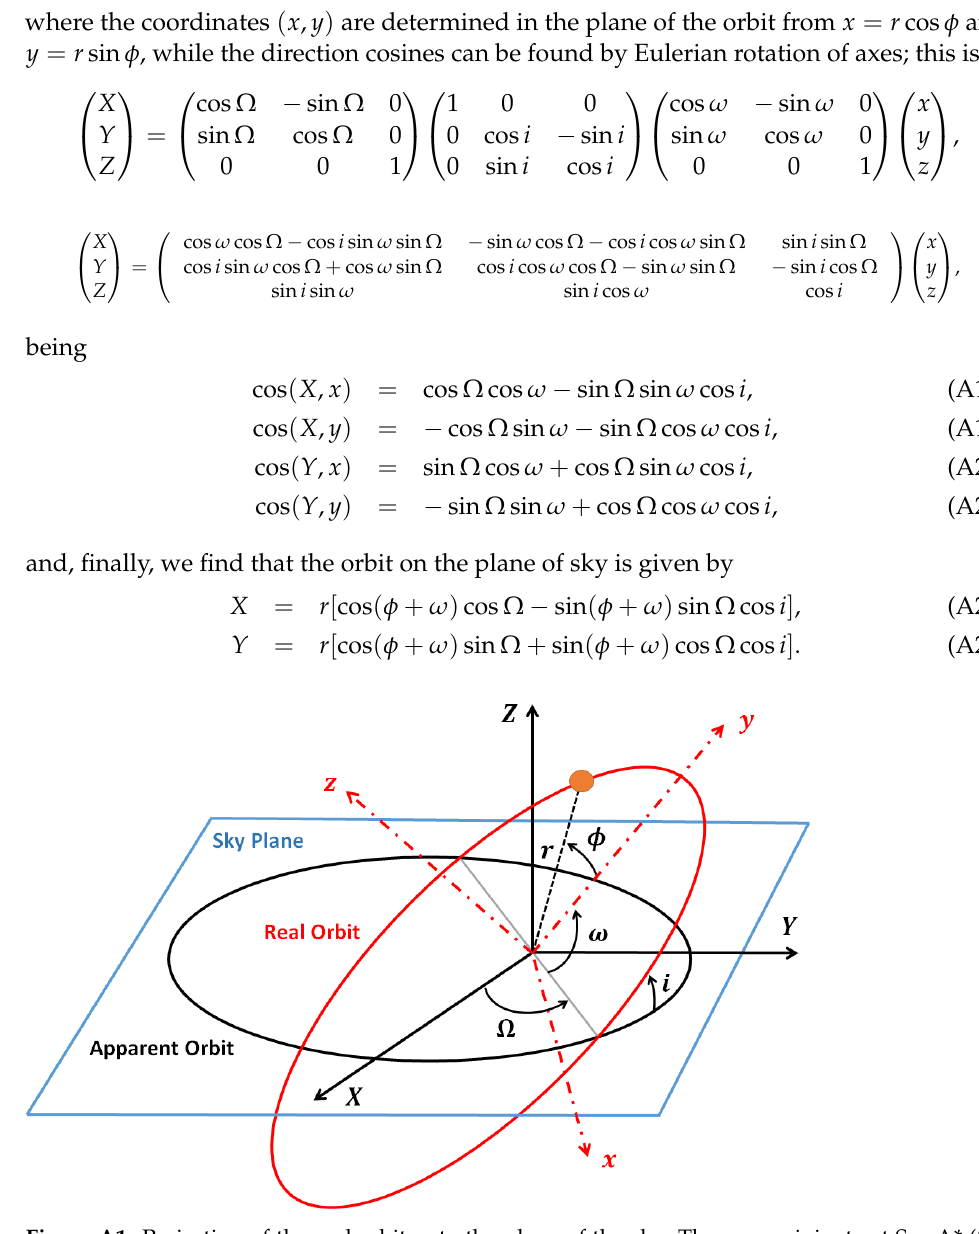
Figure A1. Projection of the real orbit onto the plane of the sky. The axes originate at Sgr A* (the focus of the ellipse). The picture illustrates the orbital parameters: φ is the azimuth angle of the spherical system of coordinates associated with the x , y , z Cartesian coordinates, i.e., for an elliptic motion in the x - y plane, it is the true anomaly; i is the angle of inclination between the real orbit and the observation plane; Ω is the angle of the ascending node, and ω is the argument of the pericenter. It is worth noting that the Z -axis of the coordinate system is defined by the vector pointing from the Solar System to the galactic center. Reproduced from [34] with permission from Astronomy & Astrophysics, Copyright